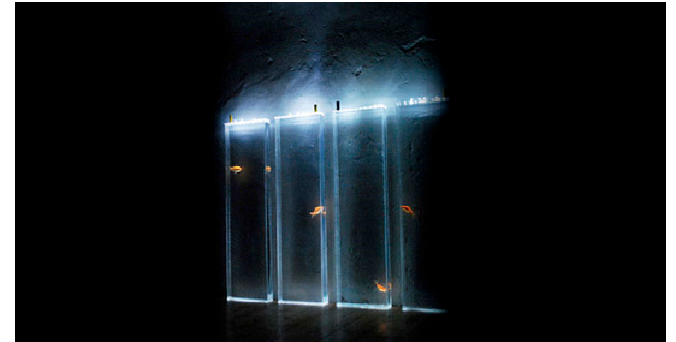
Figure 2. Fish-based instrument Quintetto by Quiet ensemble 2009 [19].